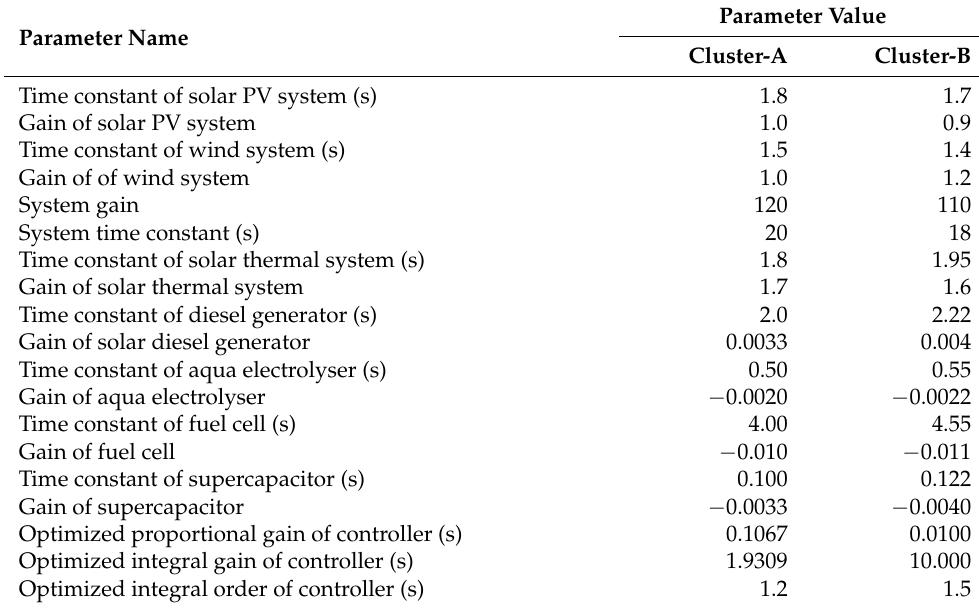
Table 1. Parameters for the microgrid clusters and